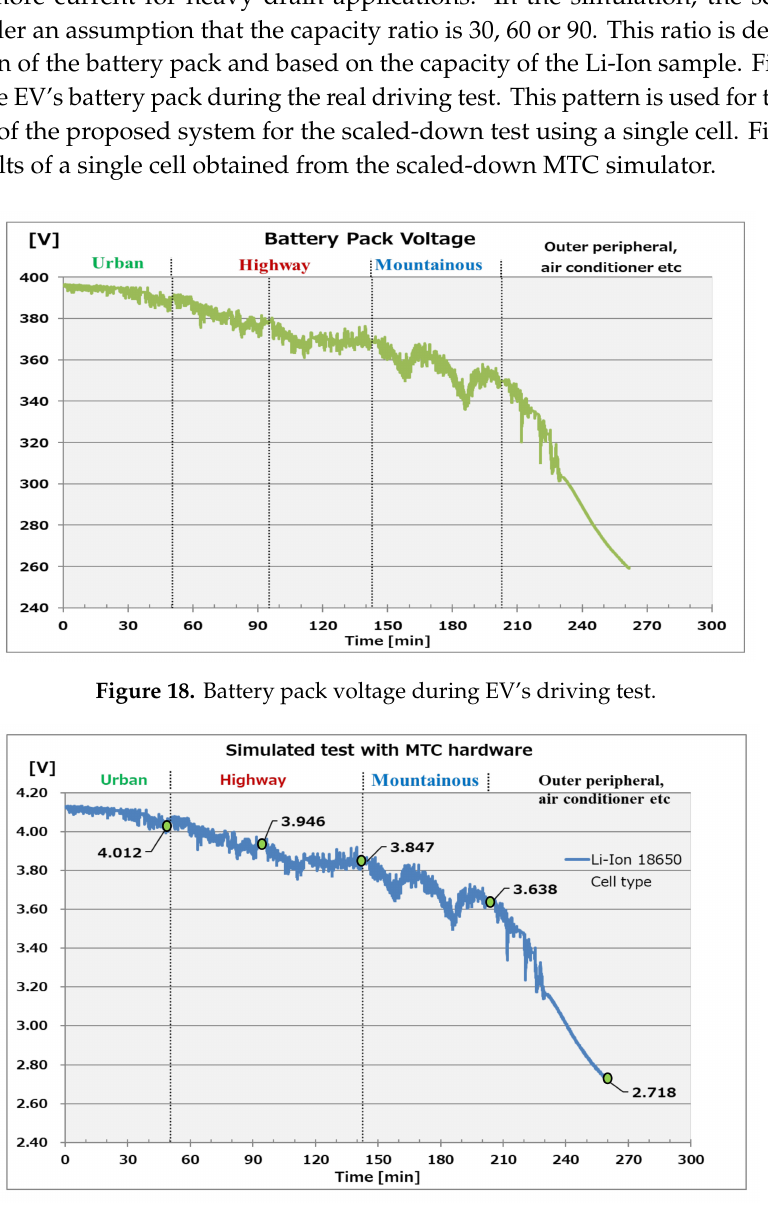
Figure 19. Single Li-Ion cell tested in the proposed scaled down